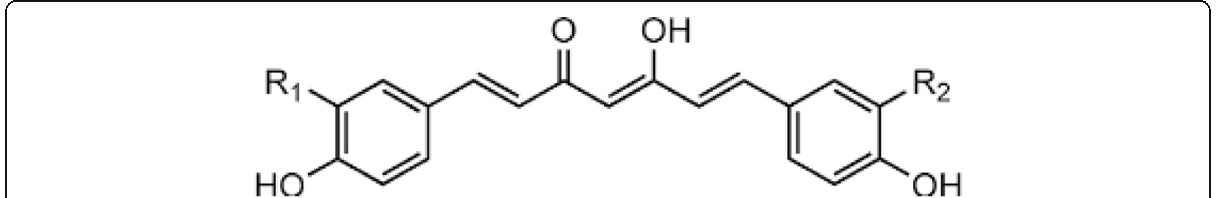
Fig. 1 Structure of curcumin, demethoxycurcumin, and bisdemethoxycurcumin. Curcumin: R 1 = R 2 = OCH 3 . Demethoxycurcumin: R 1 = H; R 2 = OCH 3 . Bisdemethoxycurcumin: R 1 = R 2 =